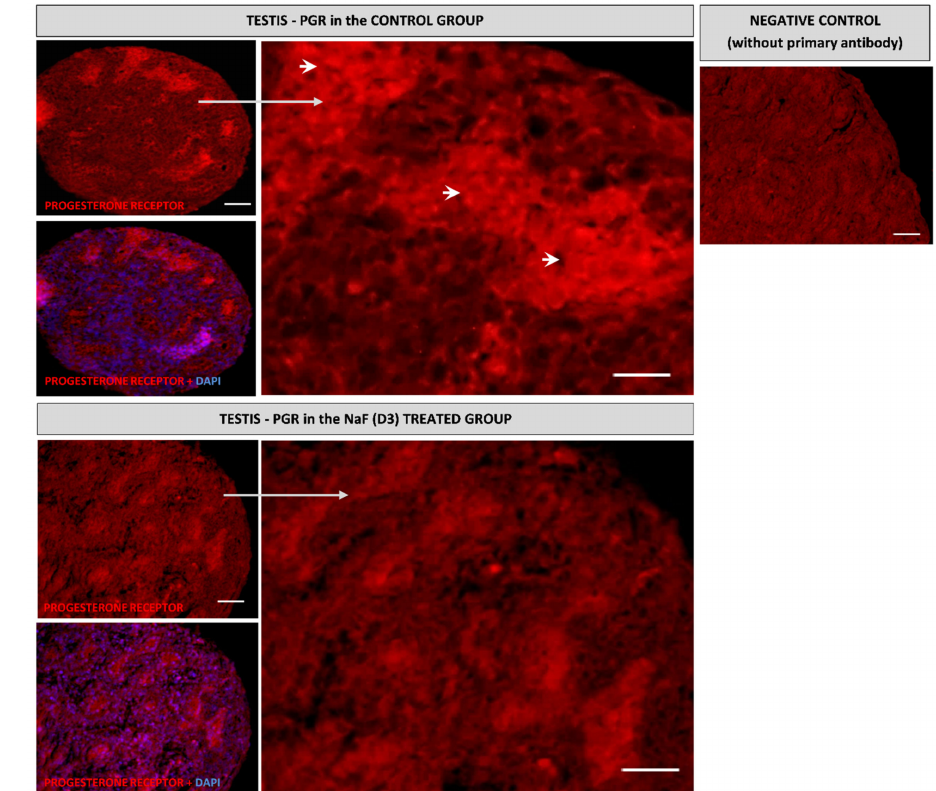
Figure 4. Immunolocalization of the progesterone receptor (PGR) in the control and NaF treated chicken embryonic testes exhibiting a developed medulla, characterized by seminiferous tubules (ST) with Sertoli cells and prospermatogonia. Arrows: Immunopositive reaction specific for the progesterone receptor (red fluorescence); DAPI: Blue fluorescence of cell nuclei. Scale bar = 100 µ